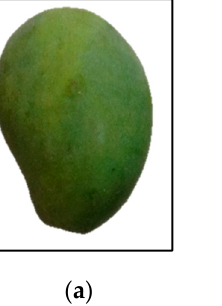
Figure 7. ( a ) Image of regular mango; ( b ) Image of misshapen mango with non-uniform edge.